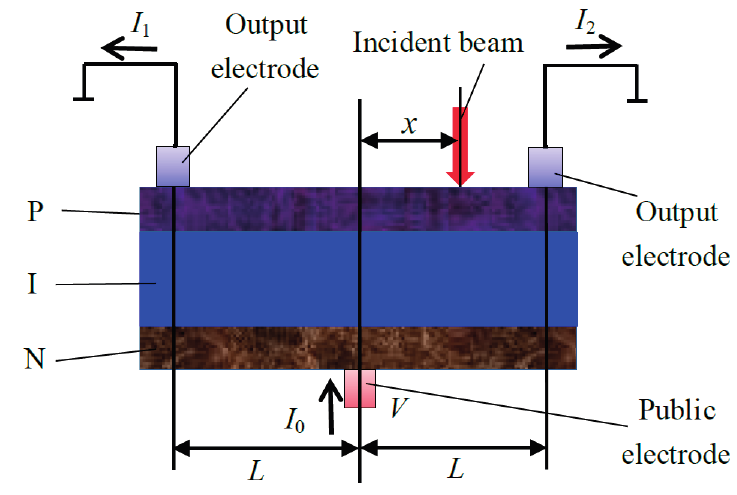
Figure 2. The structure of a Position Sensitive